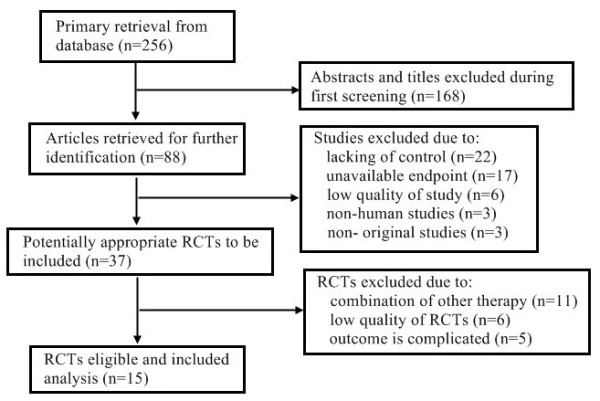
Flow chart of literature search. RCTs, randomized controlled trials.